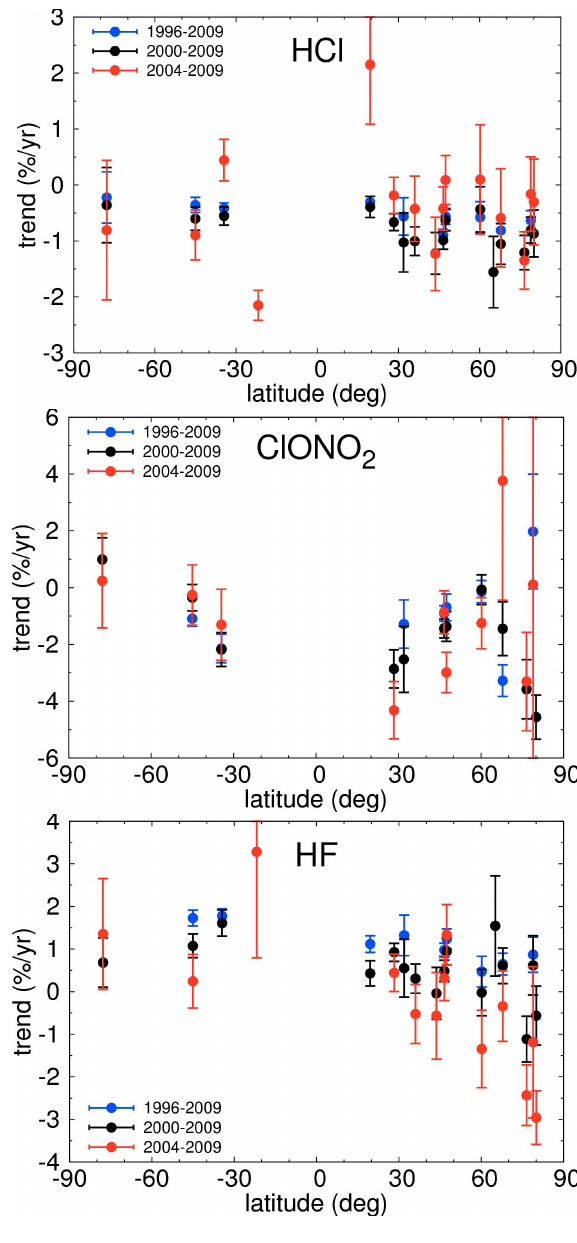
Fig. 10. Dependence of the resulting trend (in % per year) on the time period, determined for the FTIR measurements of HCl (top), ClONO 2 (mid), and HF (bottom). Please note the different y-scales. The fitting function is the linear one with seasonal cycle, which is called “standard” here. The results for 1996–2009 are shown in blue, those for 2000–2009 in black (at Toronto, this is 2002–2009, and at Poker Flat it is 2000–2004) and for the 2004–2009 period in red. The error bars were determined with the bootstrap method. Concerning the reasons for missing trend values please see